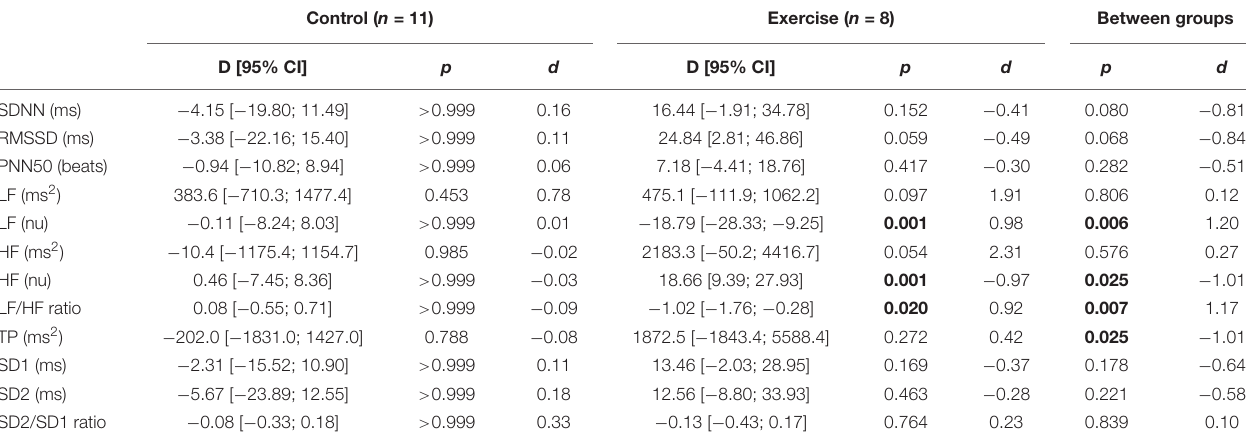
TABLE 3 | Heart rate variability within-group raw differences and between-group comparison in percent change. Control ( n = 11) Exercise ( n = 8) Between